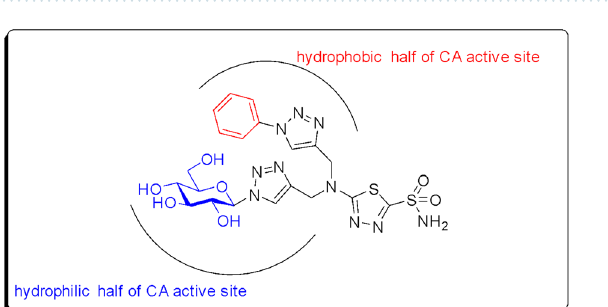
Figure 1. Reported sulfonamide-based small molecules with potent CA IX inhibition.